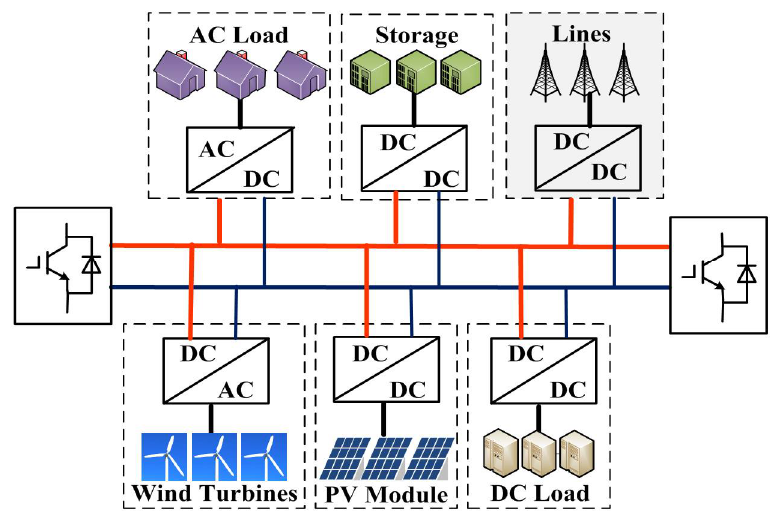
Figure 1. Radial structure of a multi-terminal DC microgrid.